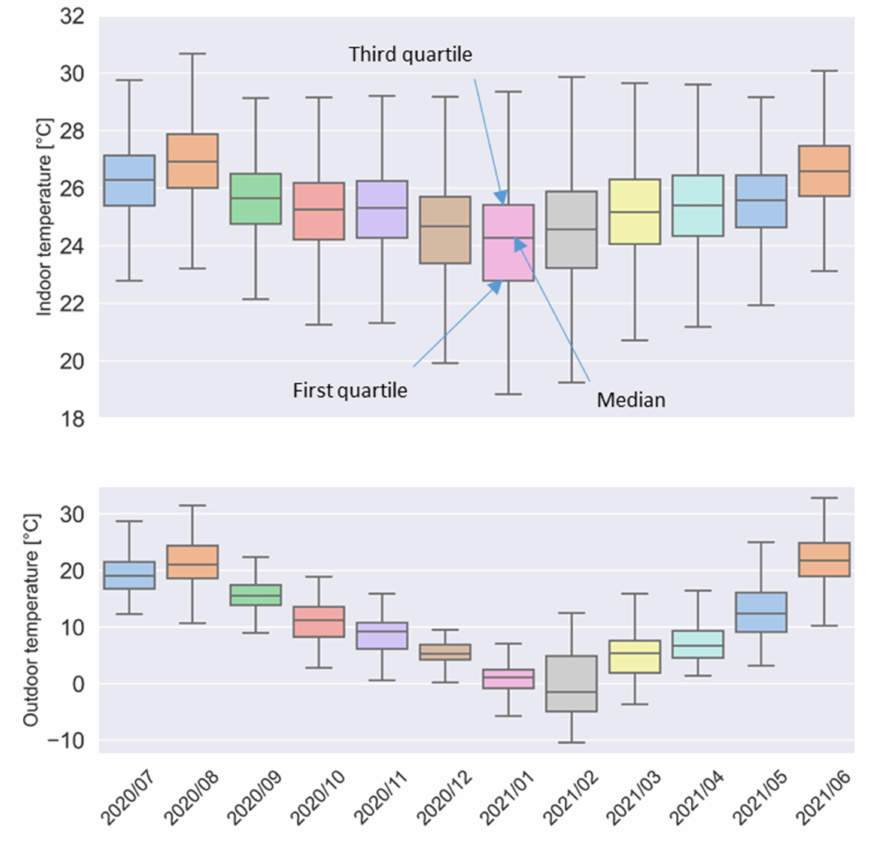
Figure 26. Monthly indoor temperature from all apartments and monthly outdoor temperature. The box plot displays median, first and third quartile values. The bar whiskers represent the maximum and minimum values, calculated through the interquartile range. Outliers are omitted in this plot.